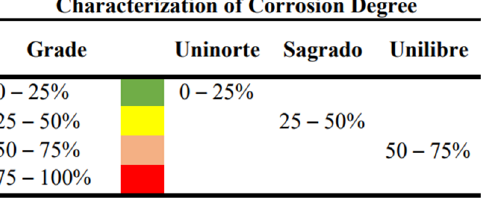
Figure 22. Characterization of bridge corrosion. Table 8. Fitted frequencies associated with the first four vertical vibration modes in